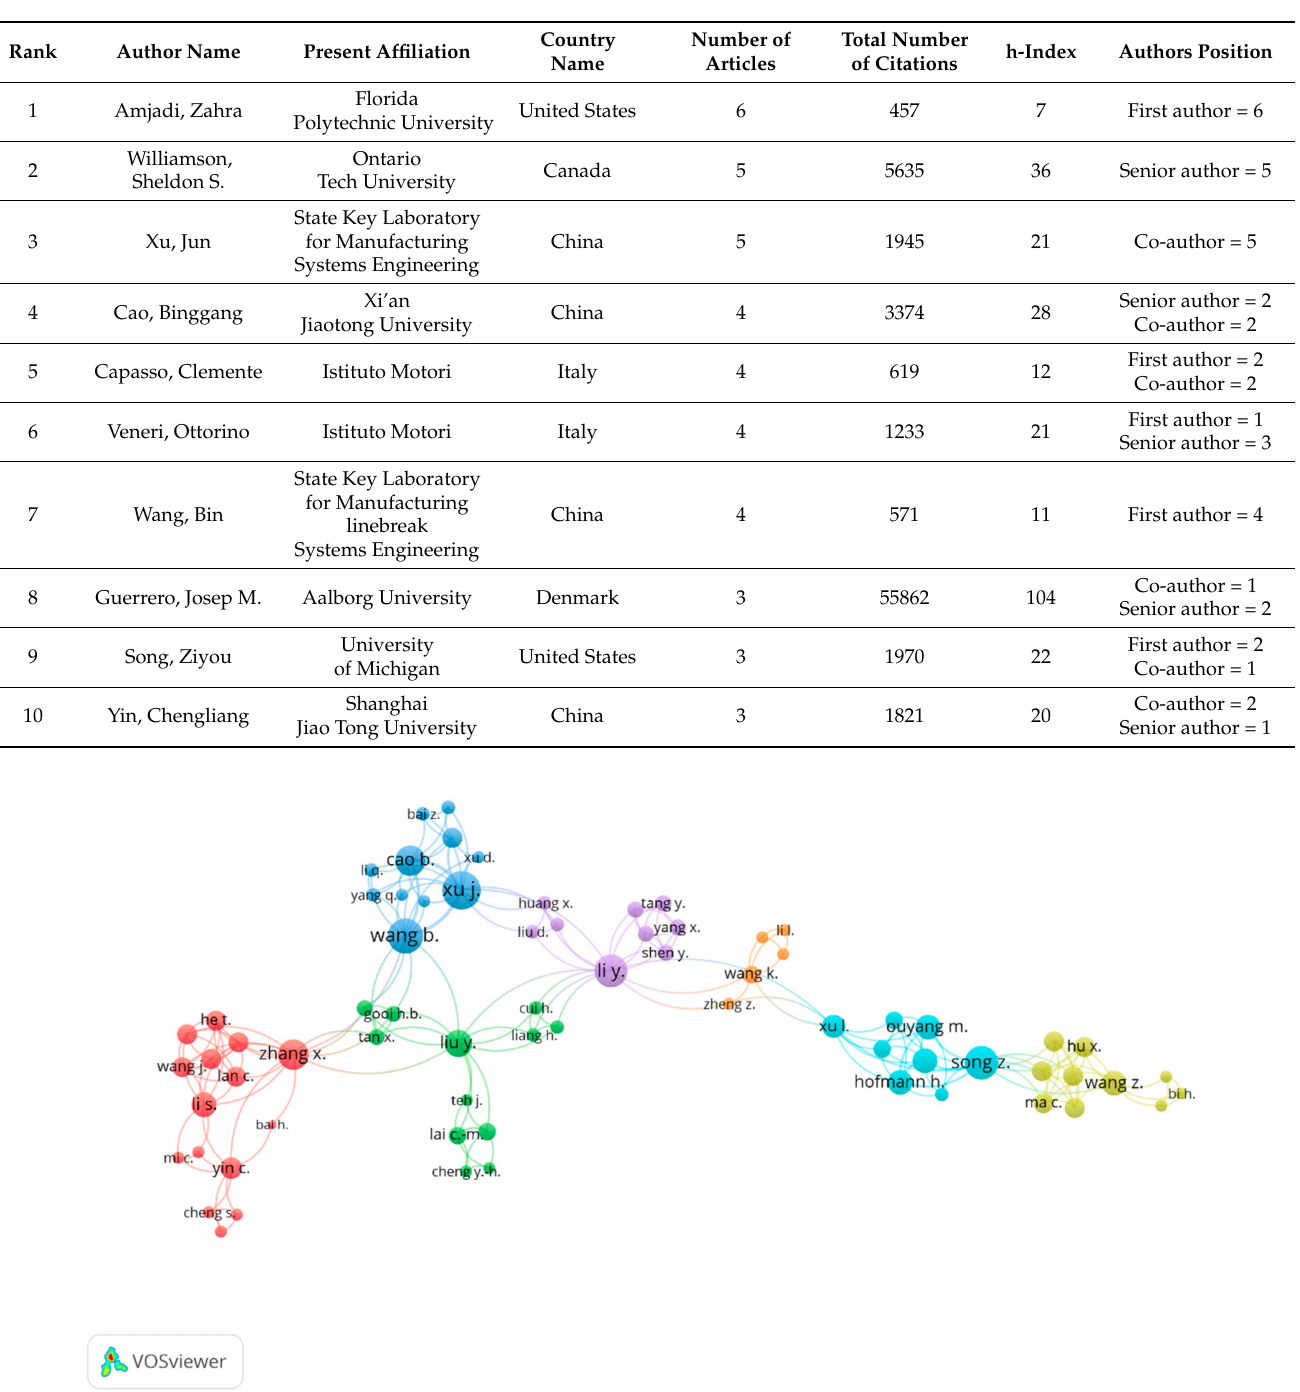
Table 10. Topmost 10 prominent authors profiles based on most relevant 100 manuscripts.